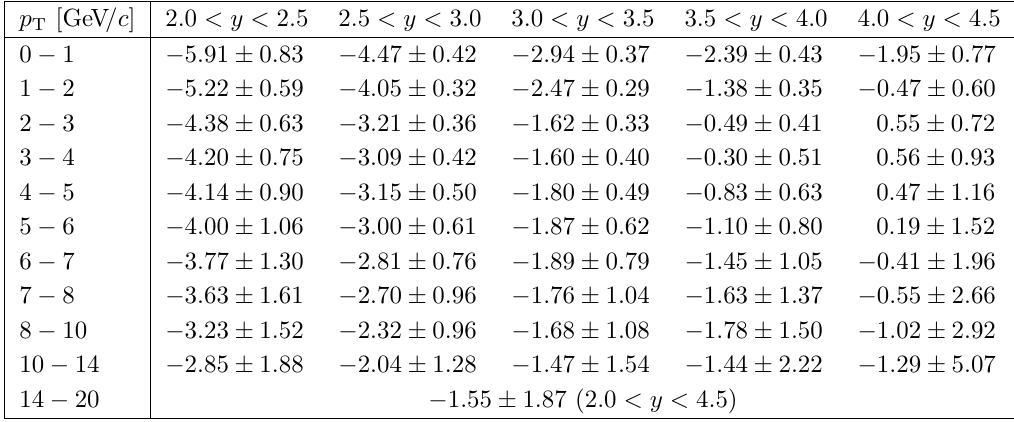
Table 18 . Relative changes of cross-sections (in %), for a polarisation of λ θ = − 0 . 2 rather than zero, in ( p T , y ) intervals.